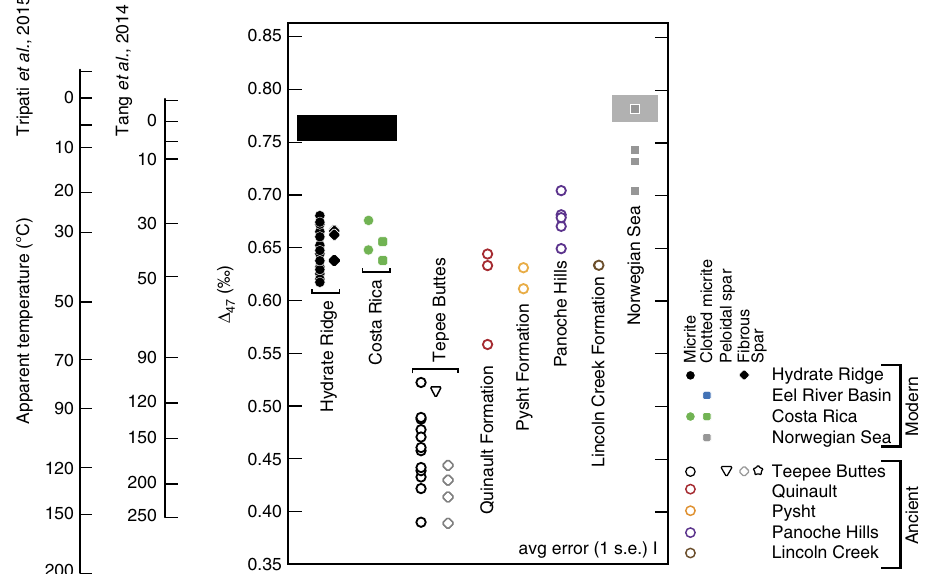
Figure 5 | Clumped isotope compositions and reconstructed temperatures. Also included are bottom water temperature ranges of the modern sites explored here. The grey envelope corresponds to Norwegian Sea and the black envelope corresponds to Hydrate Ridge and Costa Rica.